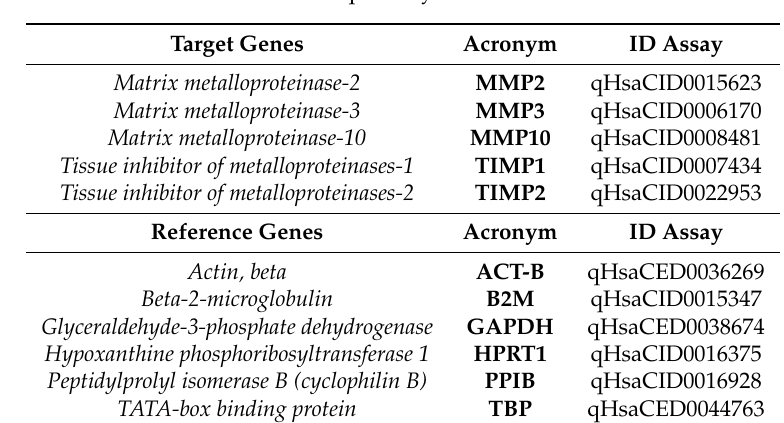
Table 1. Primers for qRT-Polymerase Chain